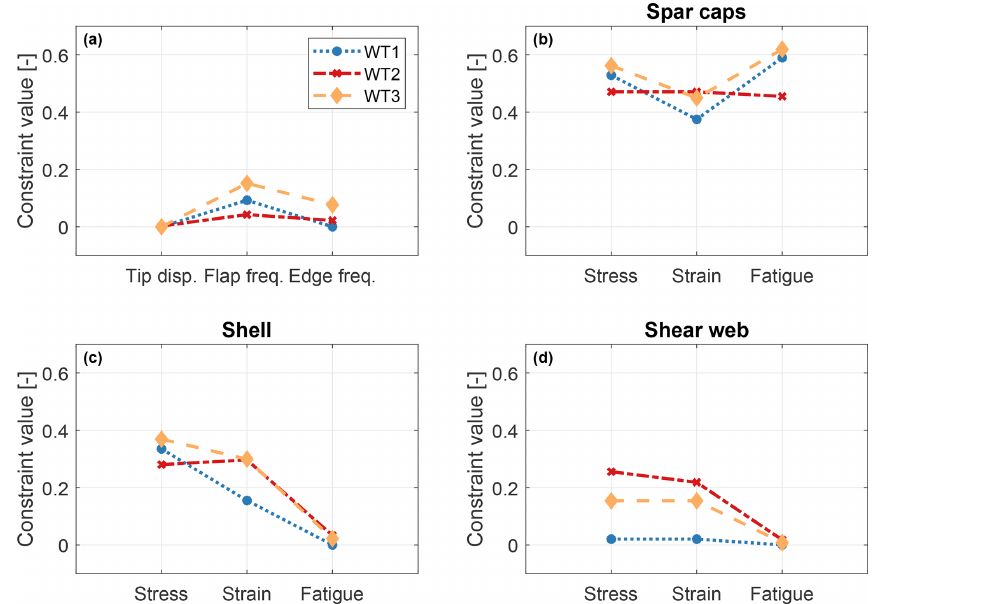
Figure 4. Rotor design constraints for tip displacement and frequency placement (a) . For a midspan section of the blade, design constraints at the spar caps (b) , shell (c) , and shear webs (d)